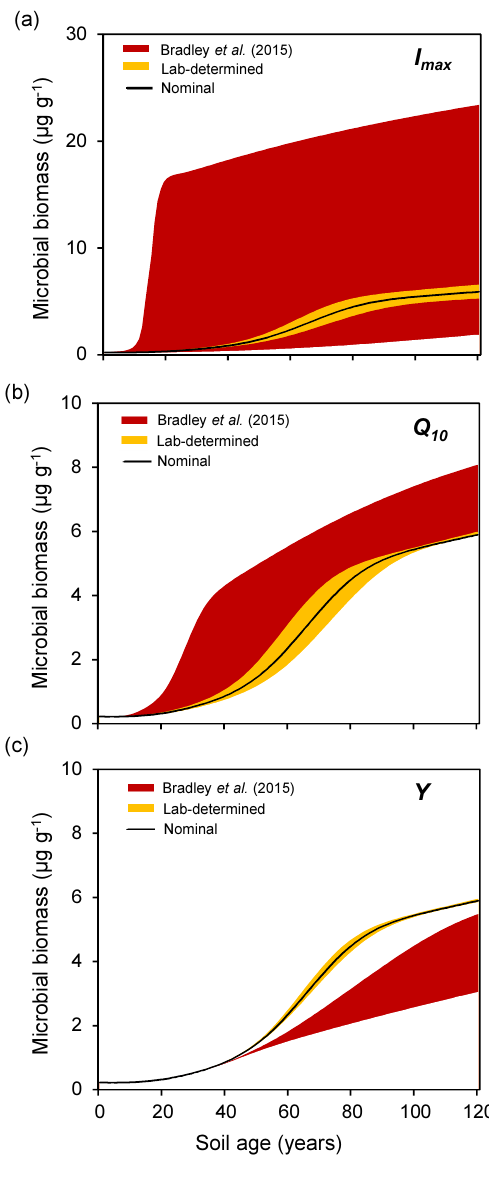
Figure 6. A comparison of predicted microbial biomass with laboratory-derived parameter values (yellow) and previously es- tablished parameter values (Bradley et al., 2015) (red) for varia- tion in the following parameters: (a) maximum growth rate ( I max ) , (b) temperature response ( Q 10 ) , and (c) BGE ( Y)